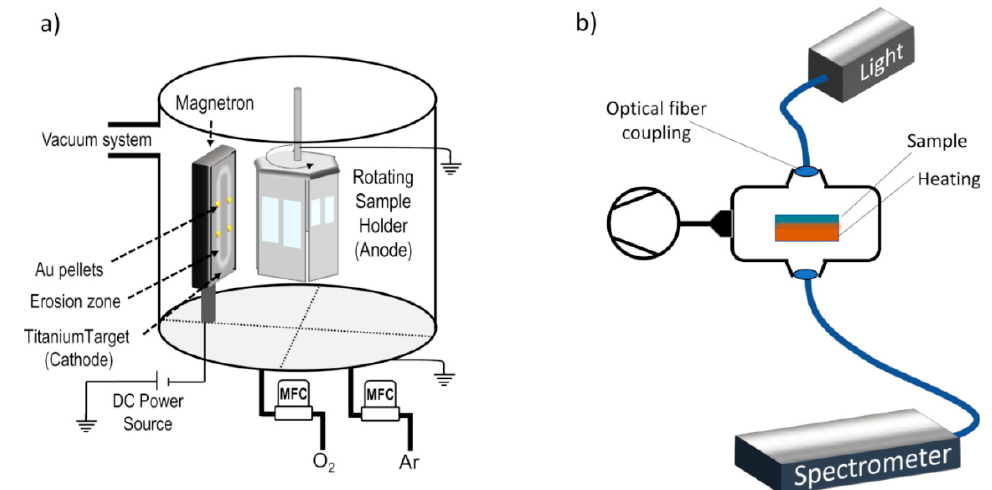
Figure 1. Simplified schematics of ( a ) the magnetron sputtering deposition system, and ( b ) custom-made optical system for transmittance-LSPR measurements in controlled atmosphere and temperature.